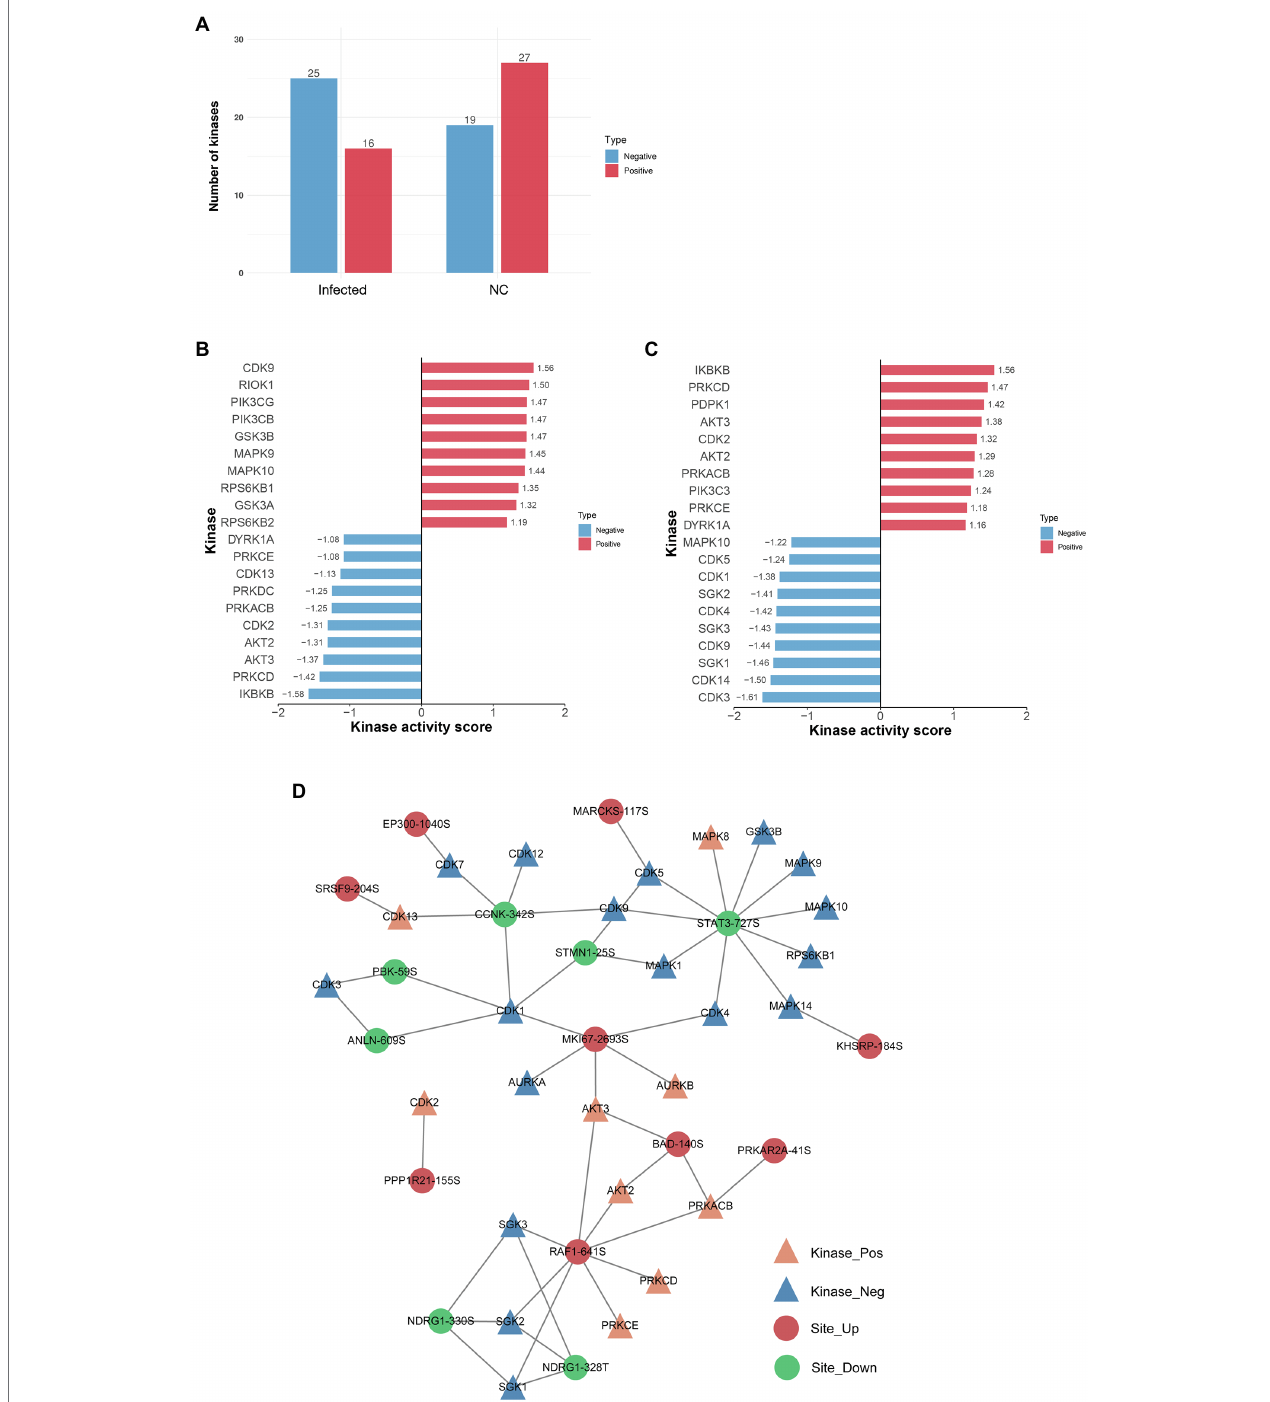
FIGURE 7 | The kinase activity of proteins with differentially regulated phosphosites. (A) Statistics of phosphokinase sample. The horizontal axis is the name of the sample, and the vertical axis is the number of kinases. The “Positive” indicates that the kinase activity tends to be activated, and the “Negative” indicates that the kinase activity tends to be inhibited. (B) Predictive analysis of phosphokinase activity in the NC group. The X -axis represents the kinase activity score, and the Y -axis is the activation or inhibition status of the kinase with the top 10 activity scores. “Positive” represents the activation status, and “Negative” represents the inhibition status. (C) Predictive analysis of phosphokinase activity in the infected group. (D) Phosphokinase-substrate regulatory network. Kinases with significantly activated (NES > 1) or inhibited activity (NES < − 1) and phosphorylation sites with significant differences in expression levels (FC > 1.5, value of p < 0.05) to construct a kinase regulatory network. Orange represents activated kinase, blue represents inhibited kinase, red represents differentially upregulated phosphosites, and green represents differentially downregulated